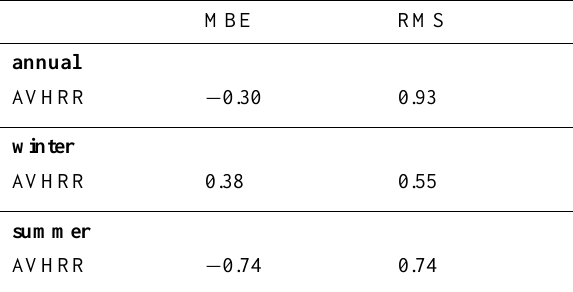
Table 2. Mean bias error (MBE) and RMS of the differences